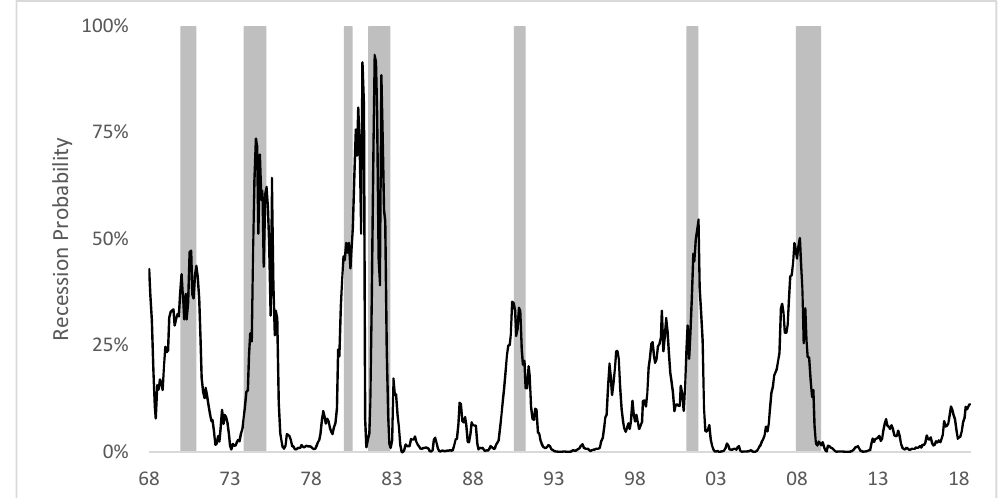
Figure 1. Probability of Recession Using the User Cost Difference.